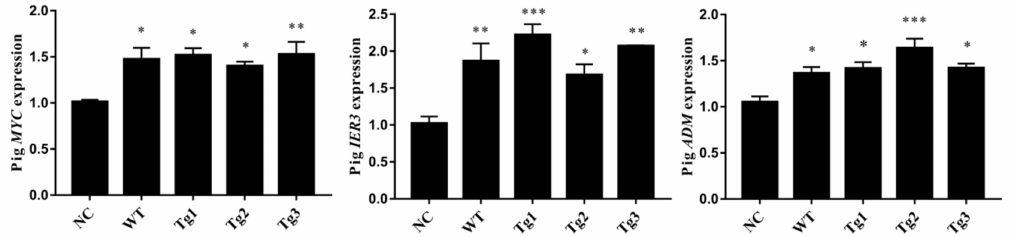
Figure 4. qRT-PCR validation of the shared upregulated DEGs. (n = 3; * p < 0.05, ** p < 0.01, *** p <